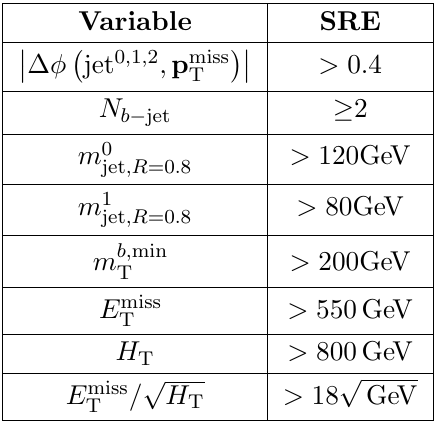
Table 4. Selection criteria for SRE in addition to the common preselection requirements described in the